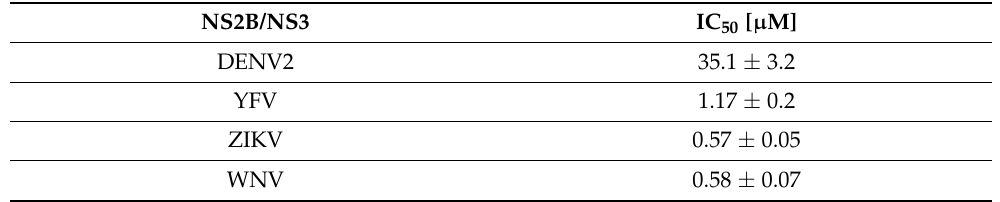
Table 6. IC 50 values of the combined EGC-EGCG